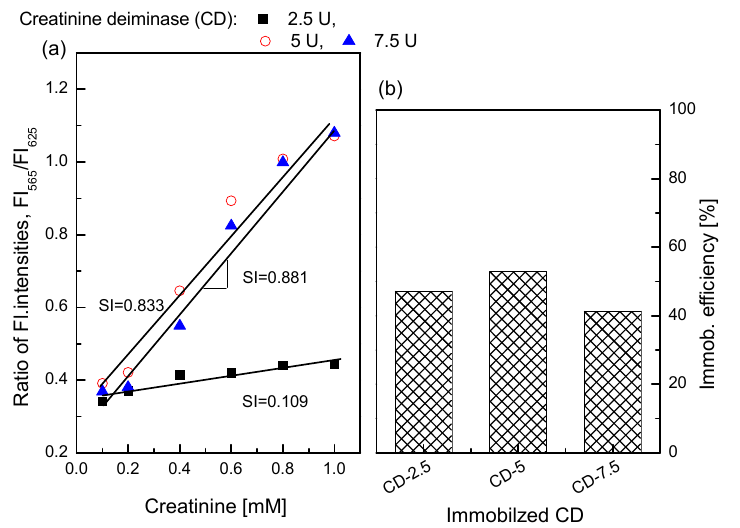
Figure 6. ( a ) The response of the creatinine-sensing membrane immobilized with 2.5, 5, and 7.5 U creatinine deiminase (CD) in the presence of 0.1 to 1.0 mM creatinine. SI represents slope value. ( b ) Immobilization efficiency of various amounts of creatinine deiminase.